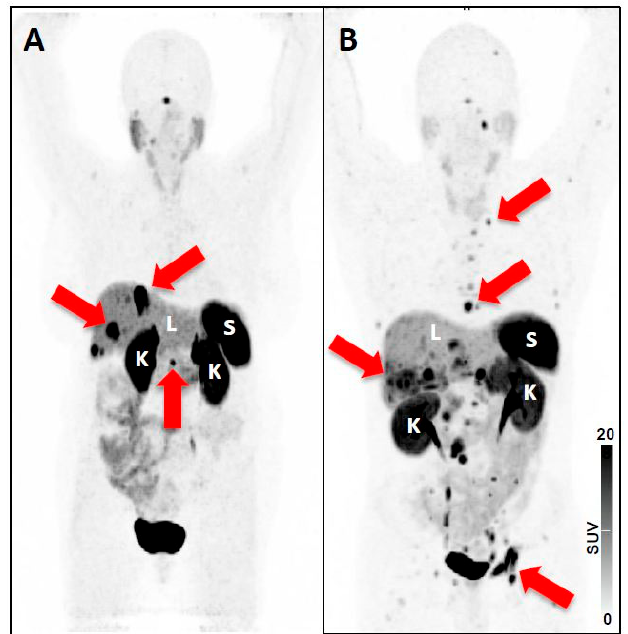
Figure 4. 68 Ga-DOTATATE maximum intensity projection (MIP) of patients with ( A ) low tumor burden, and ( B ) high tumor burden. Spleen (S), liver (L) and kidneys (K) are indicated, and the threshold has been set to a SUV of 15 in both scans. Red arrows indicate tumor lesions, which can be detected on the MIP: In Patient A SSTR-positive liver lesions and the SSTR-avid tail of the pancreas are highlighted. In Patient B several thoracic lymph node metastases are shown, but also several hepatic and bone lesions (e.g., in the acetabulum) can be detected. As 68 Ga-DOTATATE has been used, a moderate tumor-sink effect can be appreciated, e.g. when comparing the kidneys of both patients [42]. Nonetheless, the visual assessed uptake in normal organs (visible for liver, kidneys, and spleen) does not differ substantially among the different patients. Thus, in patients with extensive tumor involvement, subtle lesions close to normal organs or other tumor lesions with high uptake can be missed, which in turn may decrease absolute lesion detection rate.